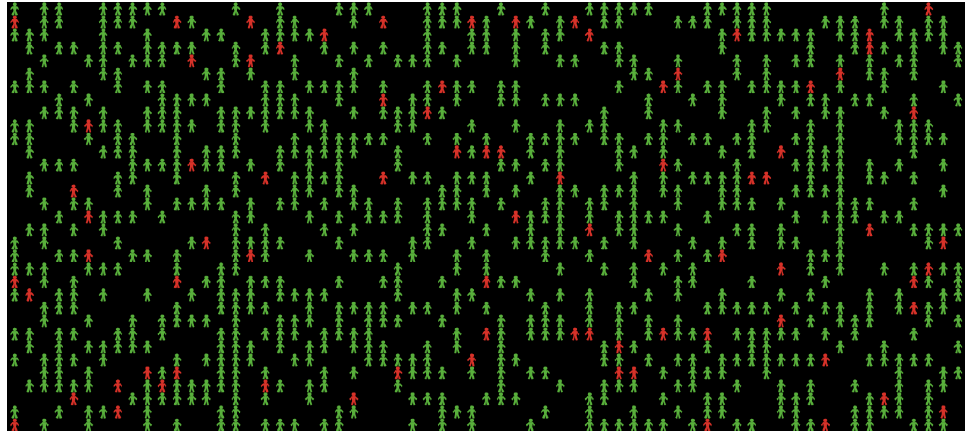
Figure 6. The initial visualization of the experiment.